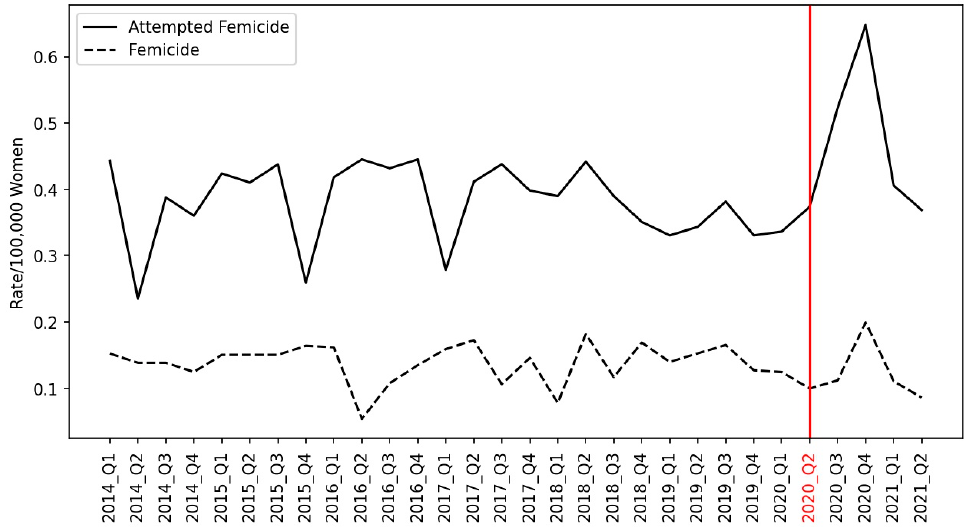
Figure 1. Rates of the attempted murder of women and of femicide between the first quarter of 2014 and the second quarter of 2021 in Chile.